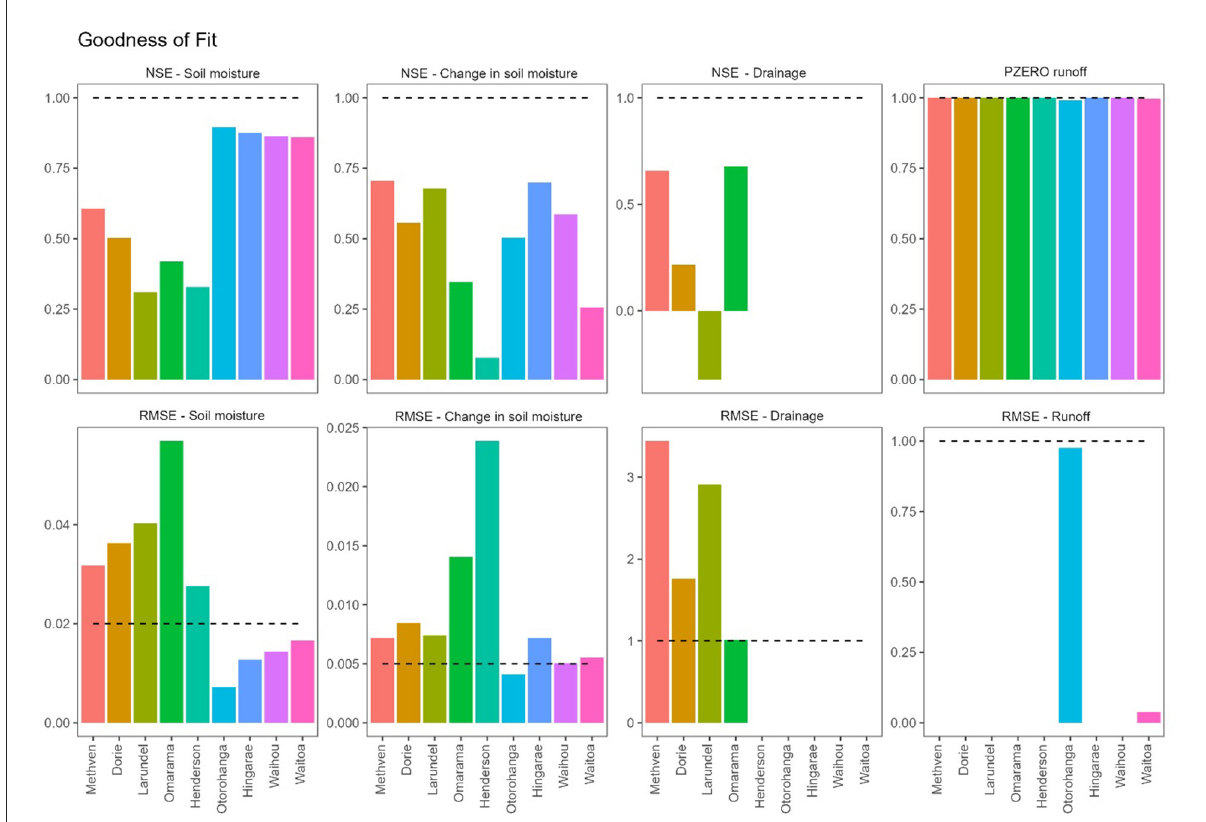
FIGURE9 Good of fit across at sites. Nash-Sutcliffe model efficiency (NSE), proportion of zero values (PZERO, for surface runoff only), and root-mean-squared error of predictions (RMSE) for each of the four calibration data series (soil water content, change in soil water content, drainage and surface runoff). Dotted lines show 1 for NSE and PZERO and assumed standard error for RMSE (see Equation